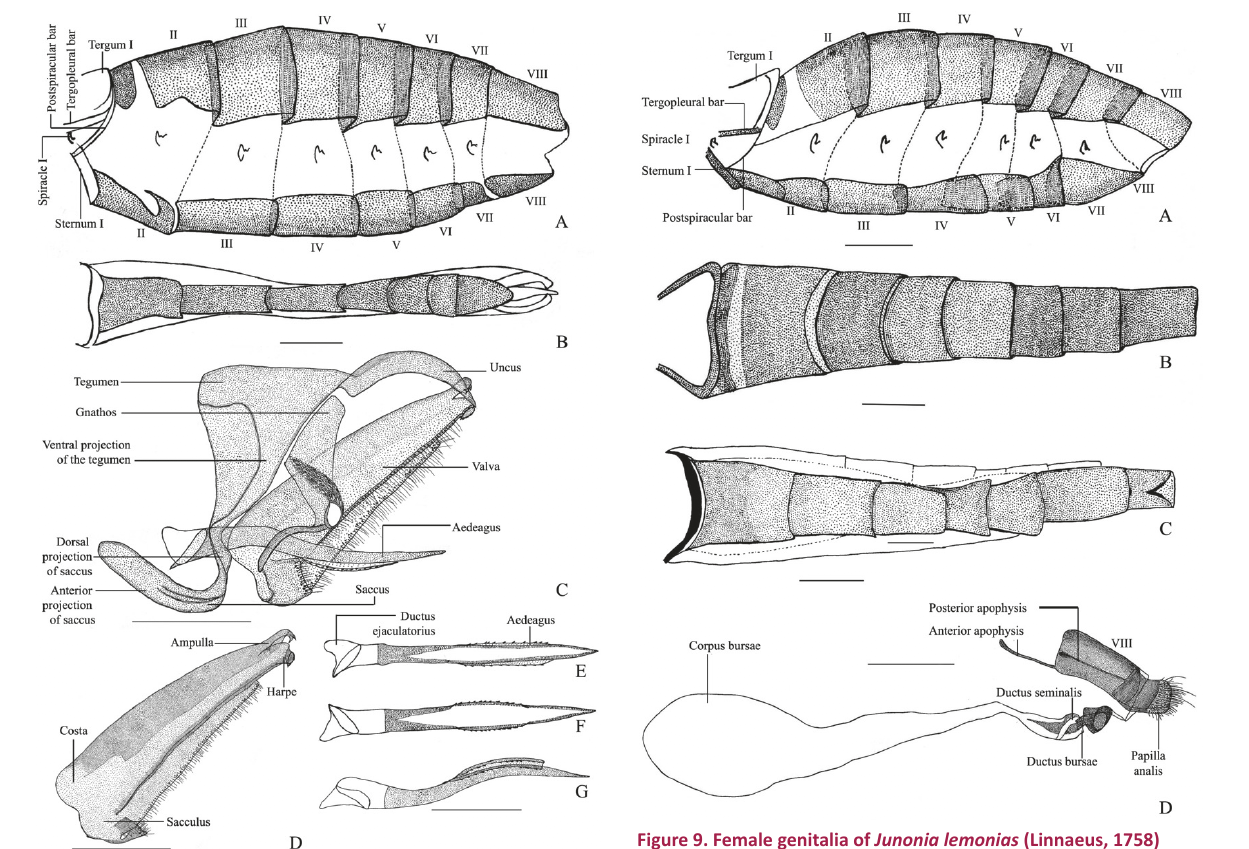
Figure 8. Male genitalia of Junonia lemonias (Linnaeus, 1758) A – B - abdomen (dorsal and ventral view, respectively); C - male genitalia (lateral view); D - right valva (inner view); E – G - aedeagus (dorsal, ventral and lateral view respectively). Scale bar 1mm.